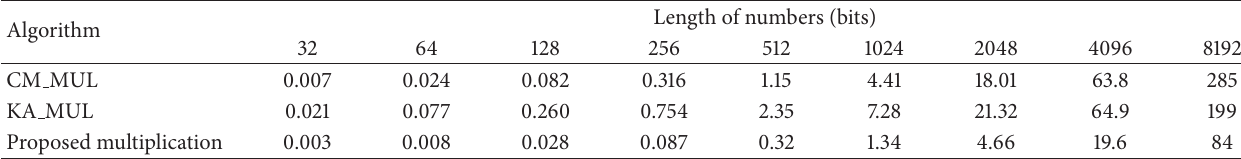
Table 4: Execution time (msec) of multiplication algorithms.